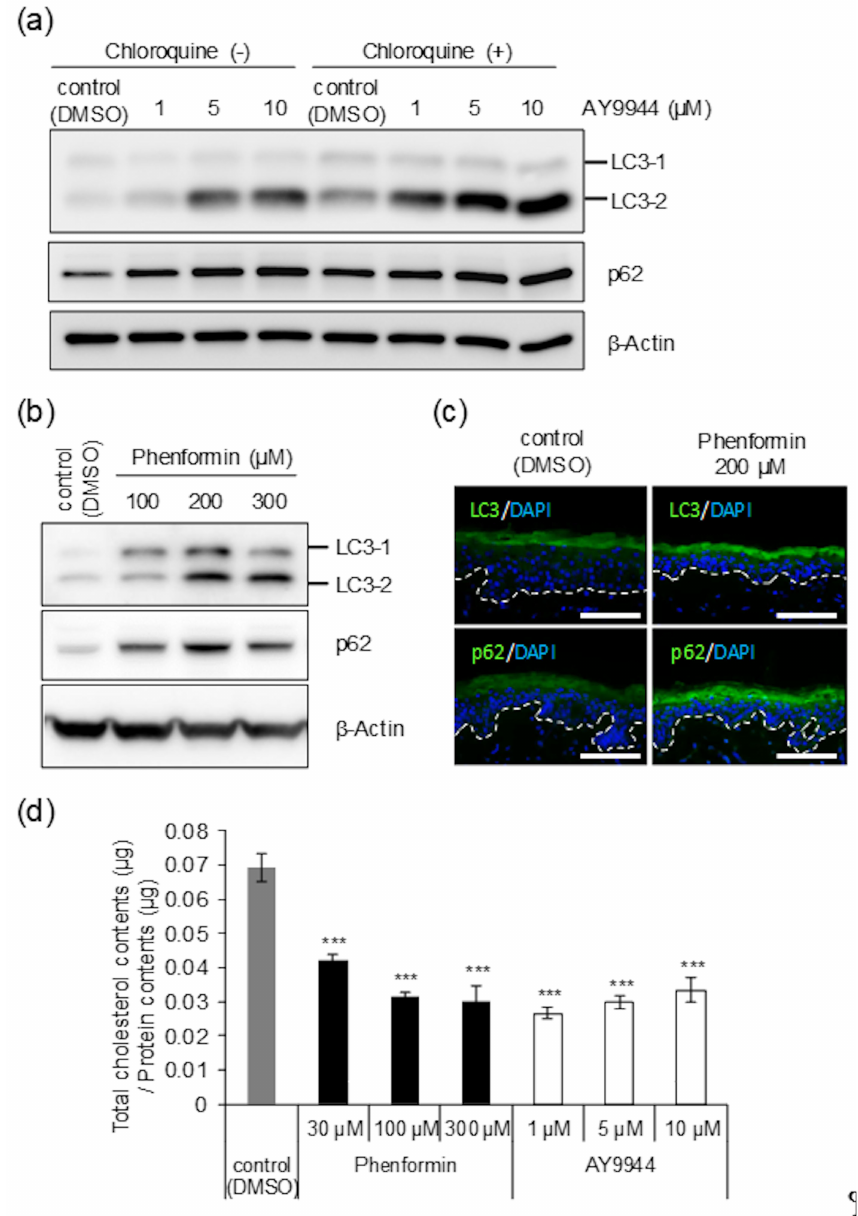
Figure 4. AY9944 diminishes autophagic activity in NHEKs similar to phenformin. ( a ) NHEKs were treated with or without AY9944 for 24 h (at the indicated concentrations) and were then further cultured with or without 10 µ M chloroquine for another 24 h. After the incubation, proteins were harvested for Western blot analysis of LC3 and p62 proteins. β -Actin was used as a loading control. ( b ) Skin tissues obtained from an AA subject (43y) were treated with or without phenformin for 4 days (at the indicated concentrations). After the treatment, proteins were extracted for Western blot of LC3 and p62 proteins. β -Actin = loading control. ( c ) Skin tissues obtained from the AA subject above were treated with or without 200 µ M phenformin and were used for immunofluorescence staining with an anti-LC3-antibody and an anti-p62 antibody. Scale bars = 100 µ m. ( d ) NHEKs were treated with DMSO, phenformin or AY9944 for 3 days (at the indicated concentrations) and then collected for the quantification of cellular cholesterol content. Values are means ± SD of 3 independent samples (*** p < 0.001 versus control (DMSO treatment) by Dunnett’s